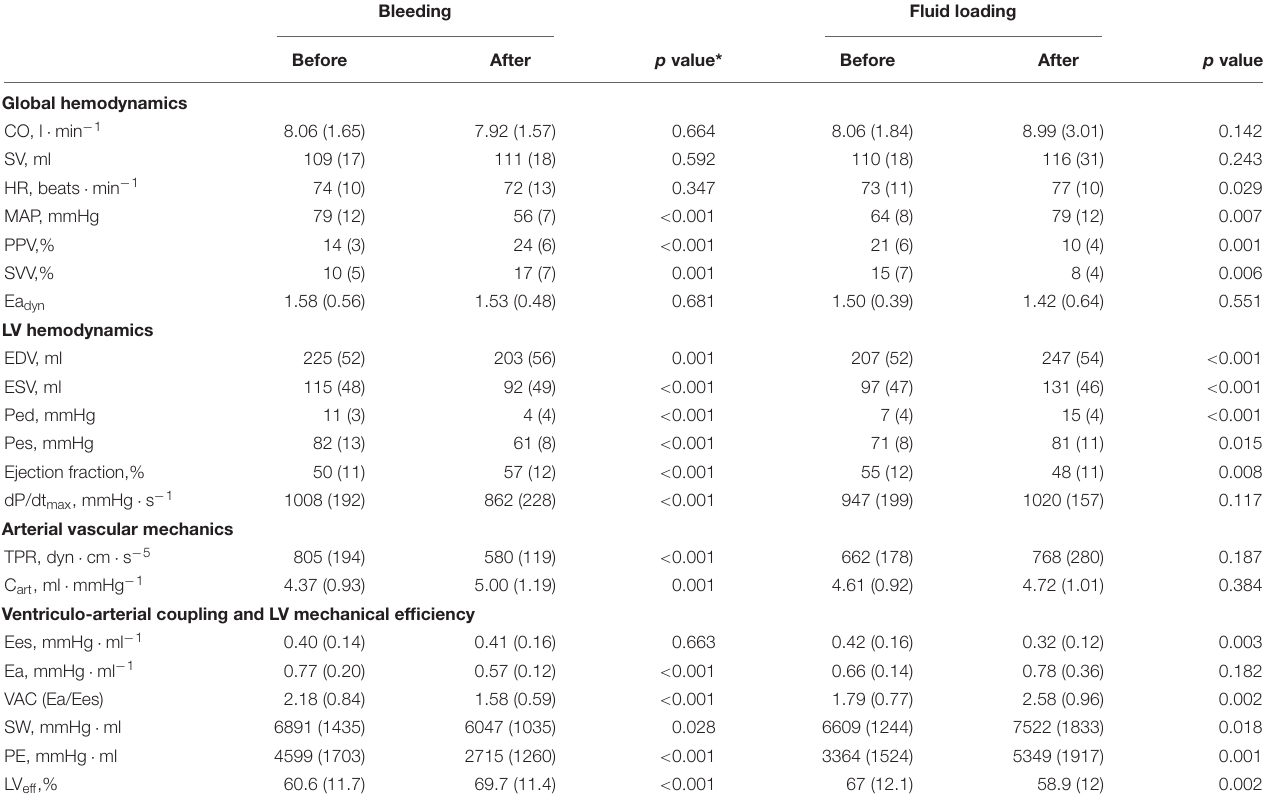
TABLE 2 | Hemodynamic variables during preload changes. Bleeding Fluid